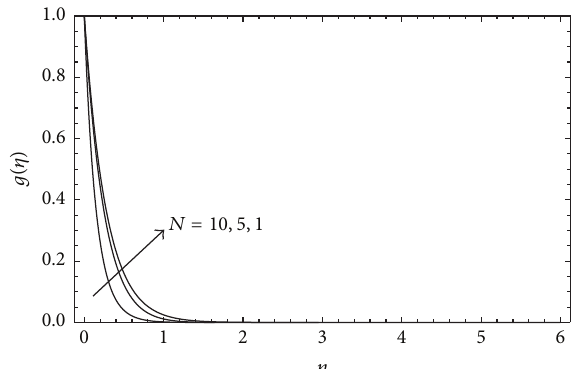
Figure 13: Variation of temperature profiles with 𝑁 for 𝑀 = 1, Pr = 0.7 , and 𝐾 = −2 𝑤